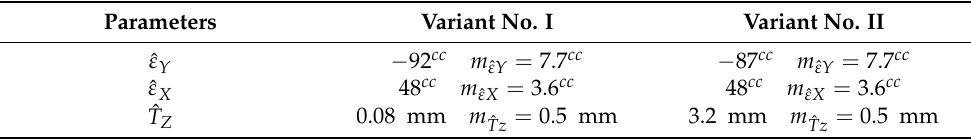
Table 5. The obtained model’s parameters and their mean errors. Parameters Variant No.